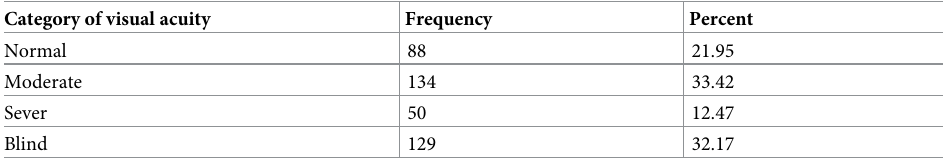
Table 2. Frequency distribution of visual acuity.